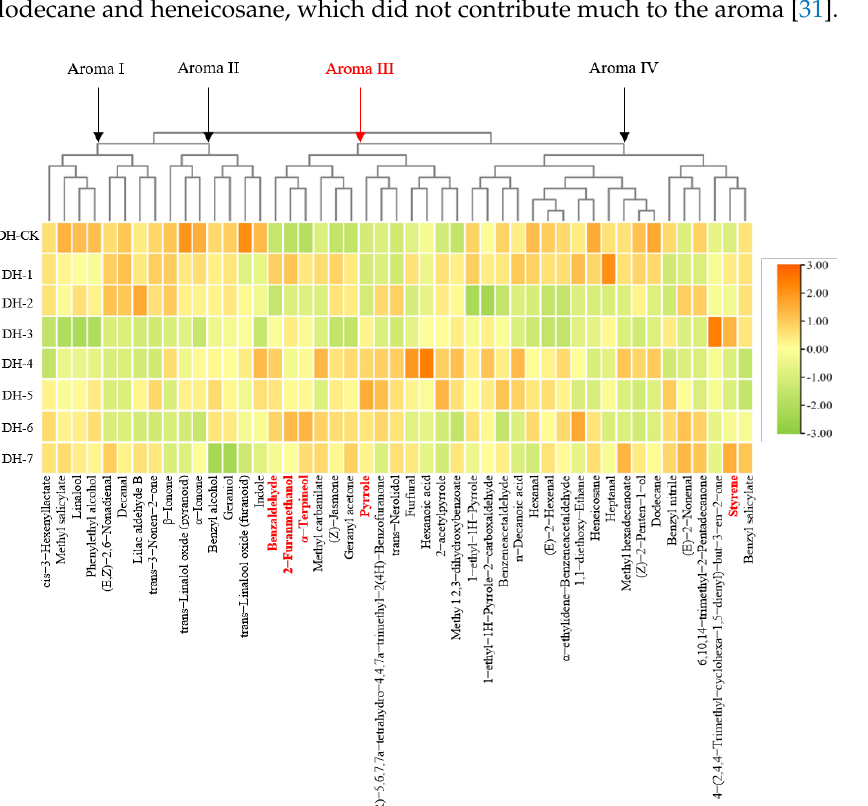
Figure 4. Changes of the total relative content of the four cluster classification aroma compounds in aroma-enhanced Yunnan congou black teas baked at 90 °C (0 – 7 h). Note: Values in each group la- beled with different letters (a – d) differ significantly ( p < 0.05). 3.4. Multiple Factor Analysis (MFA) of Aroma Attributes and Volatile Compounds of Yunnan Congou Black Tea Baked at 90 °C